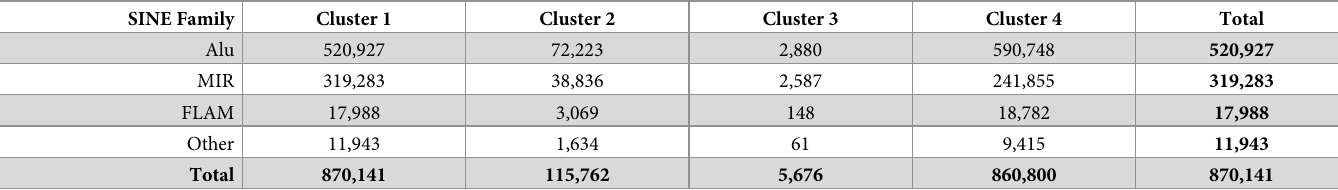
Table 7. Clustering of SINE